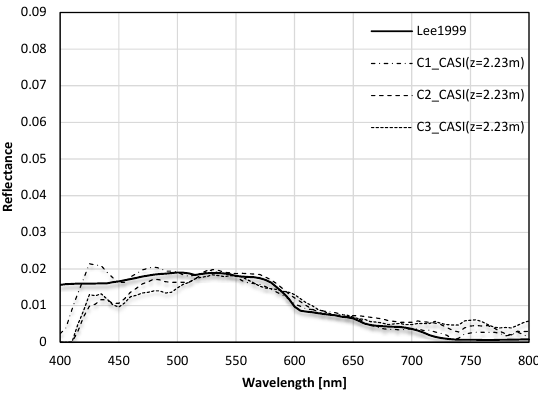
Figure 5. Seagrass spectral simulation at 2.23m water